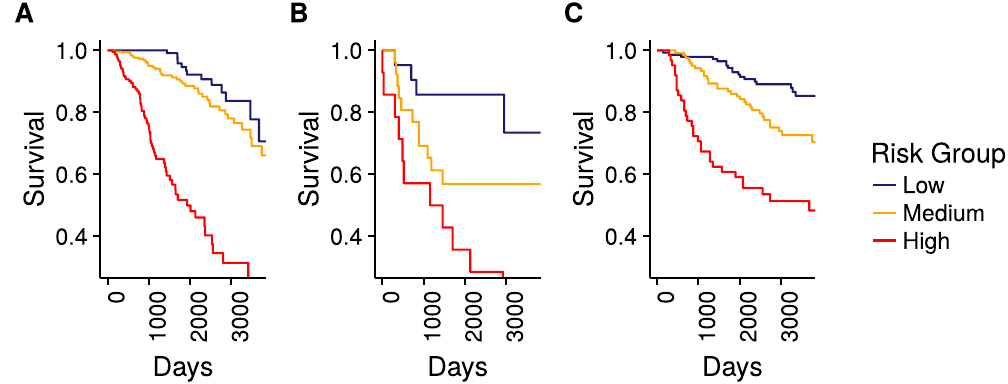
Figure 3. Kaplan-Meier plots of survival in the overall survival datasets shown out to 10 years. In each dataset, the samples were split into three risk groups based on their predicted M2EFM risk score: ( A ) TCGA, ( B ) Terunuma, ( C ) Kao. The three risk groups (denoted Low, Medium, and High), appear to have good discrimination on all datasets. In each case, the Low risk group had the best survival and the High risk group the worst.